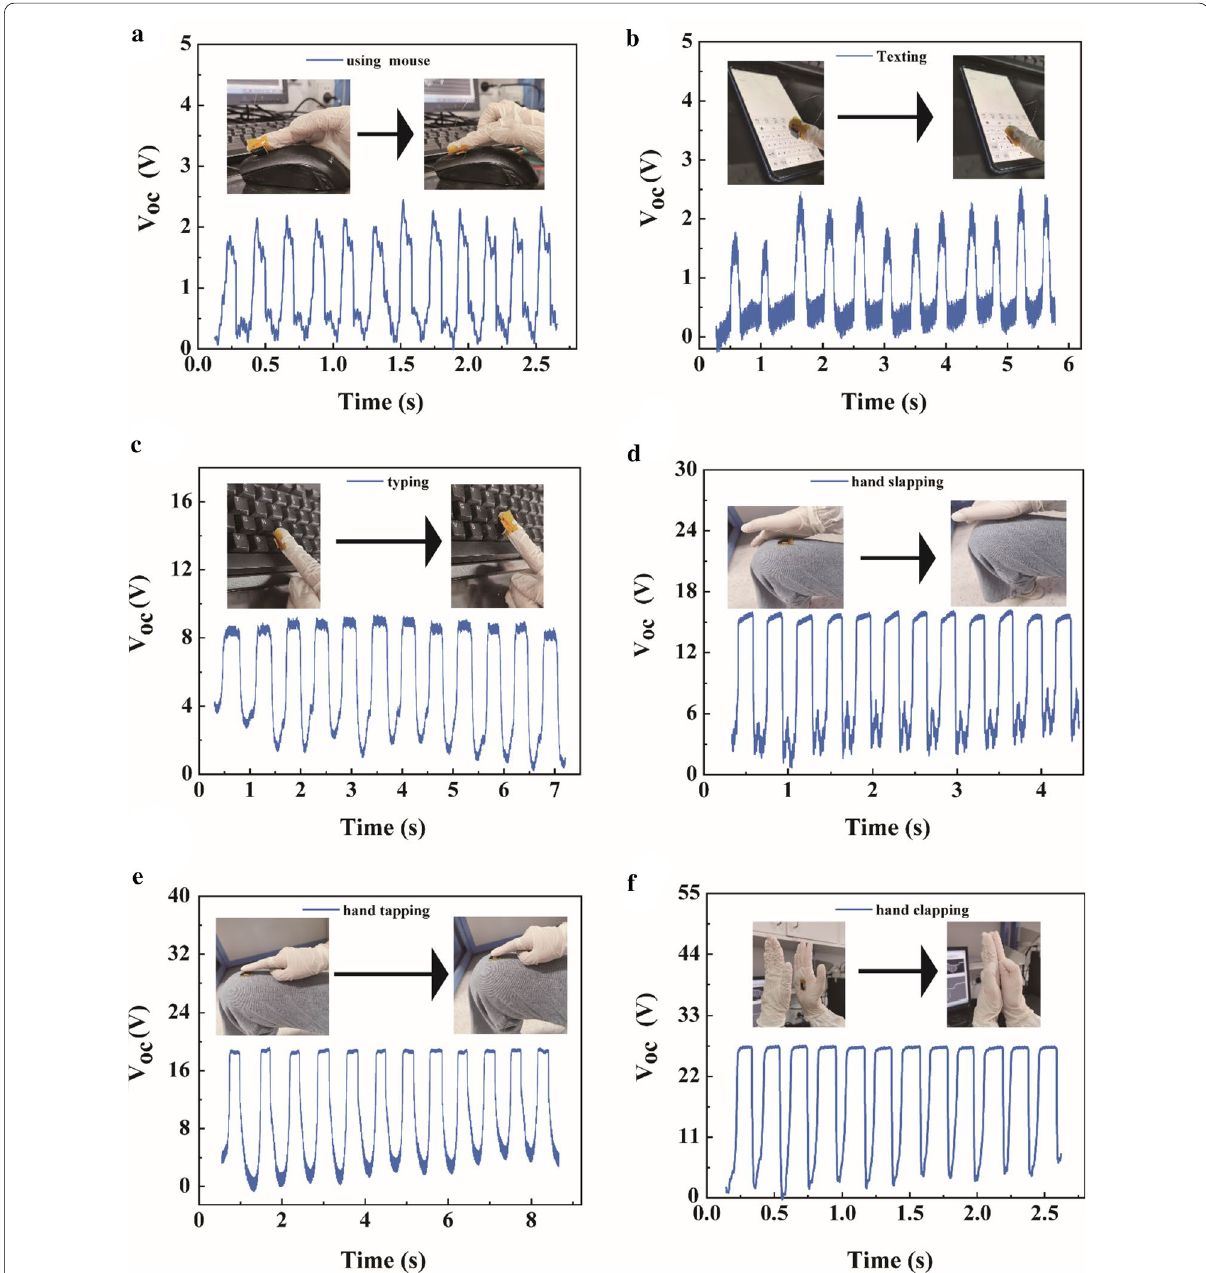
Fig. 5 V oc signals of AM-TENG under different motion states. a Using mouse, b Texting, c Typing, d Hand slapping, e Hand tapping, f Hand